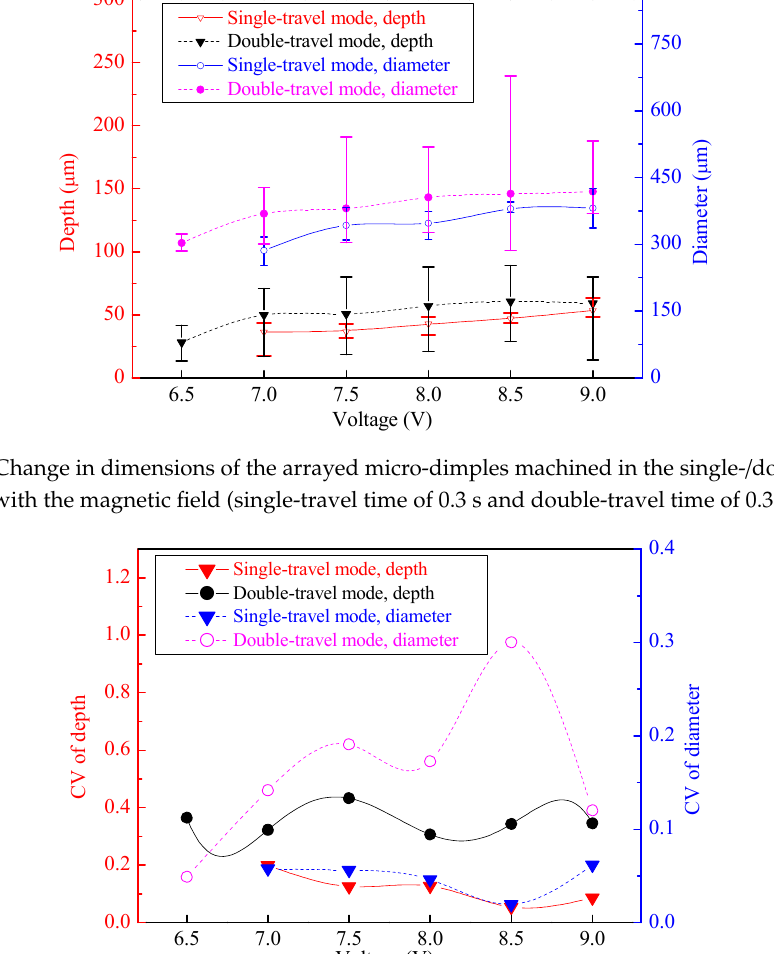
Figure 11. Change of dimensional coe ffi cient of variation (CV) of the arrayed micro-dimples machined in the single- / double-travel mode and with the magnetic field (single-travel time of 0.3 s and double-travel time of 0.3 × 2 s).